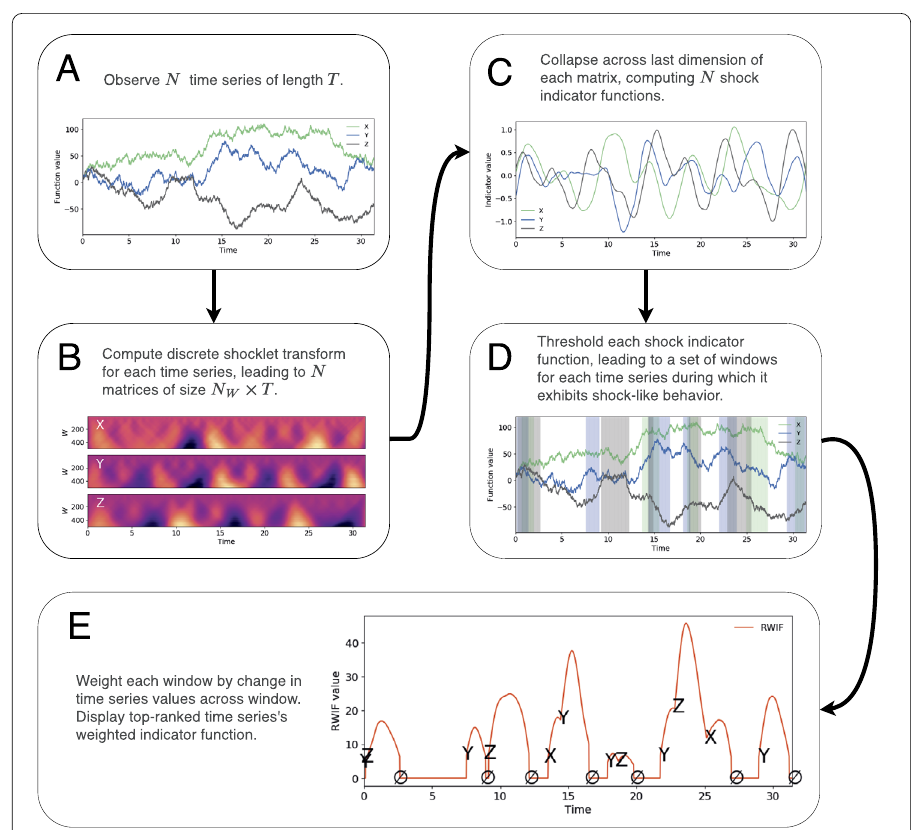
Figure 7 STAR. The Shocklet Transform And Ranking (STAR) algorithm combines the discrete shocklet transform (DST) with a series of transformations that yield intermediate results, such as the cusp indicator function (panel ( C ) in the figure) and windows during which each univariate time series displays shock-like behavior (panel ( D ) in the figure). Each of these intermediate results is useful in its own right, as we show in Sect. 2. We display the final output of the STAR algorithm, a univariate indicator that condenses information about which of the time series exhibits the strongest shock-like behavior at each point in time